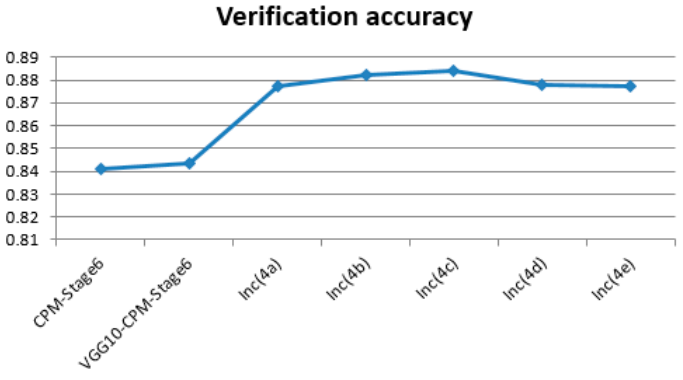
Figure 5. The verification accuracy comparisons of these models.